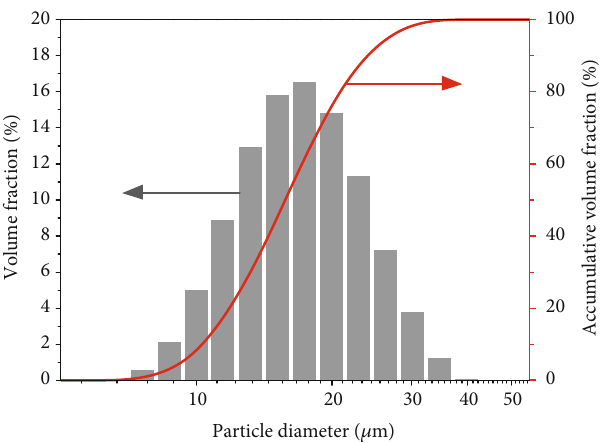
Figure 1: Particle size distribution of micron aluminum powder.